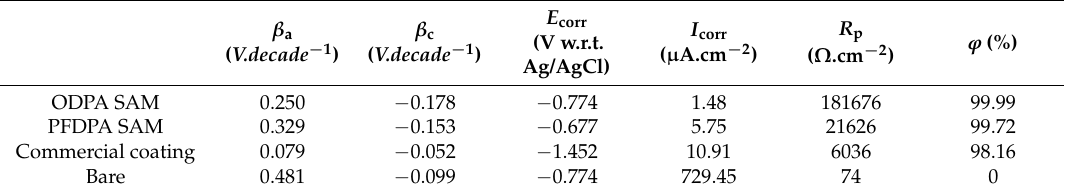
Table 1. Corrosion performance data for the octadecylphosphonic acid (ODPA) and 1H, 1H (cid:48) , 2H, 2H (cid:48) -perfluorodecyl phosphonic acid (PFDPA) self-assembled monolayers (SAMs), and commercial coating incorporated TiO 2 nanotube arrays